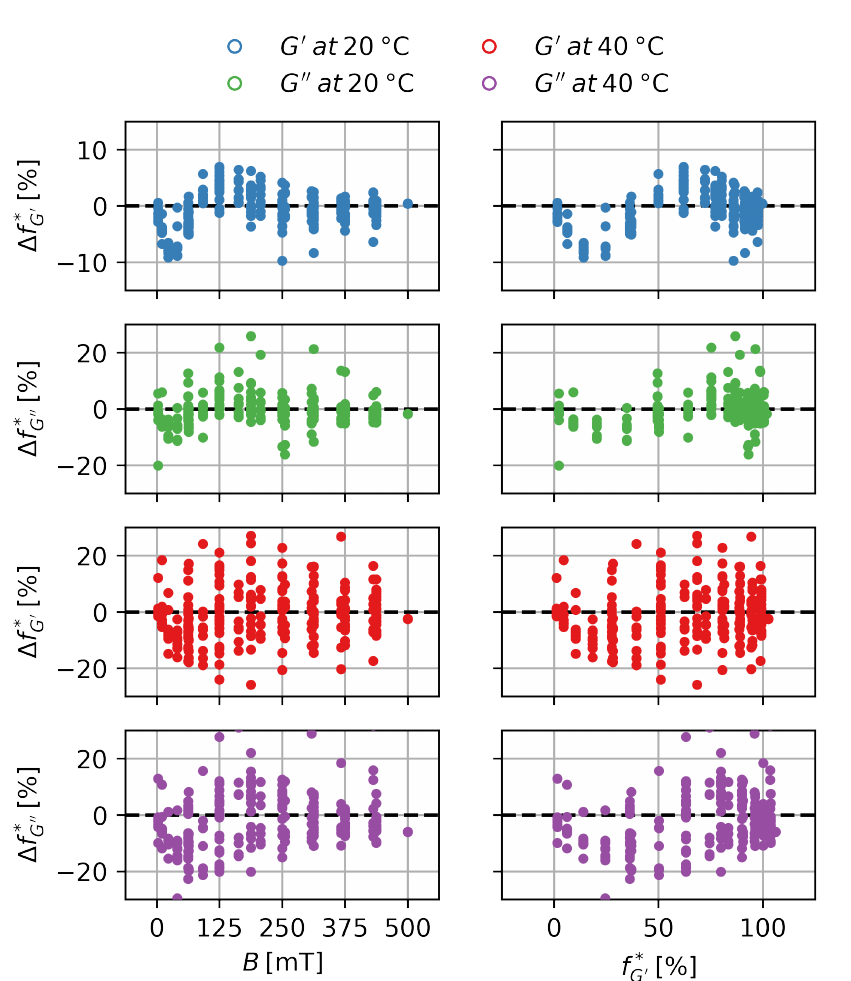
Figure 12. Residuals over the independent value B and the fitted value f ∗